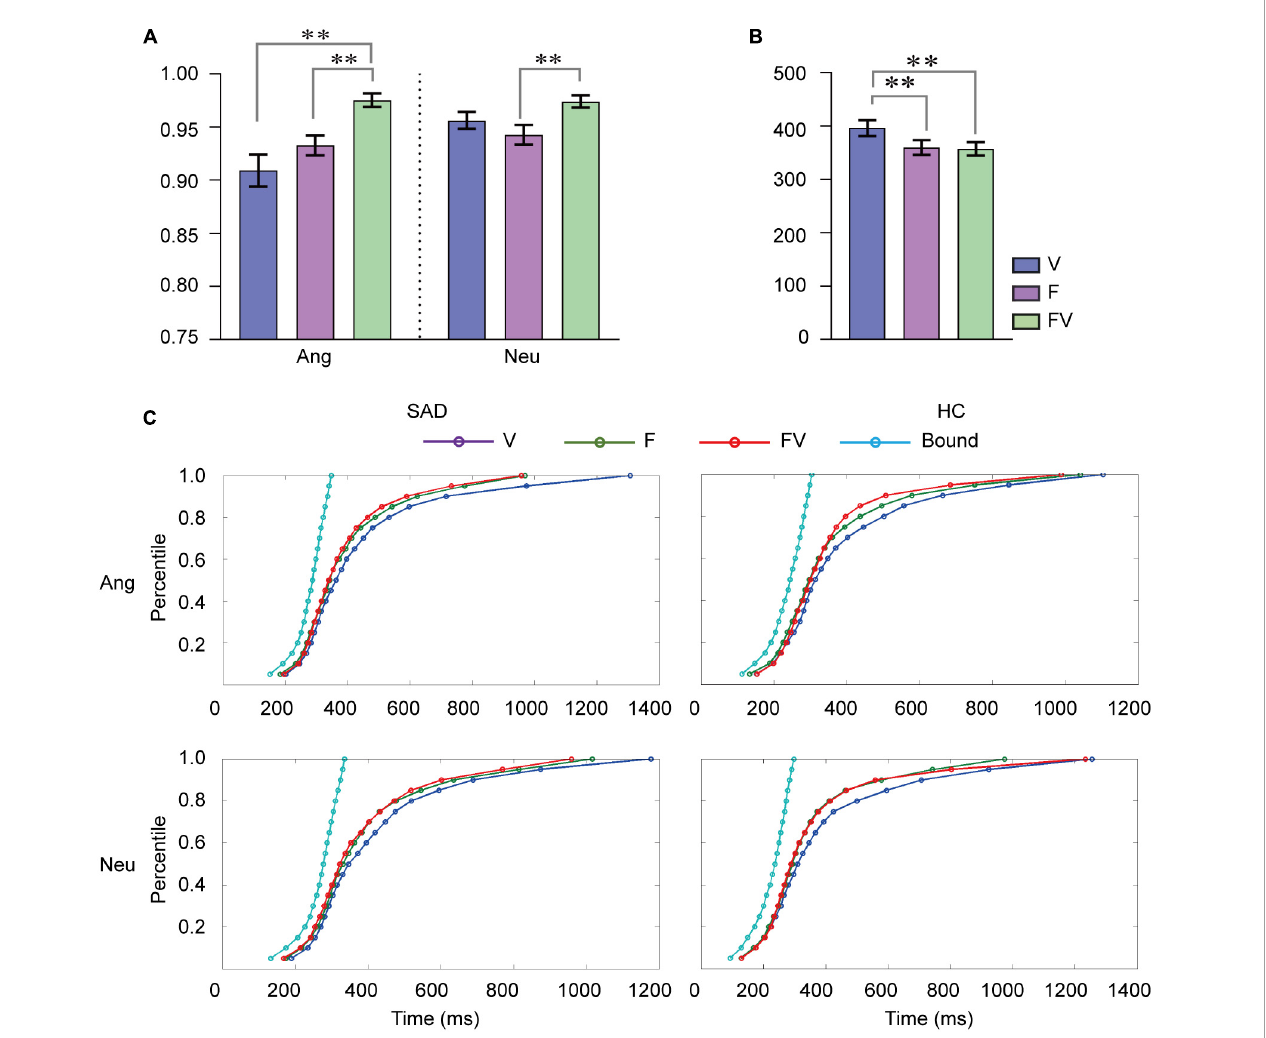
FIGURE1 Behavioral results. (A) Mean categorization accuracy for faces, voices and bimodal combinations in angry, and neutral trials. (B) Mean RT (ms) to faces, voices and bimodal combinations. F, faces; V, voices; FV, bimodal combinations; Ang, angry trials; Neu, neutral trials. Error bars indicate ± SEM. (C) Cumulative density functions (CDFs) for F, V, and FV and the bound values predicted by RMI for RT in angry and neutral trials for the SAD and HC groups separately. ∗∗ p <